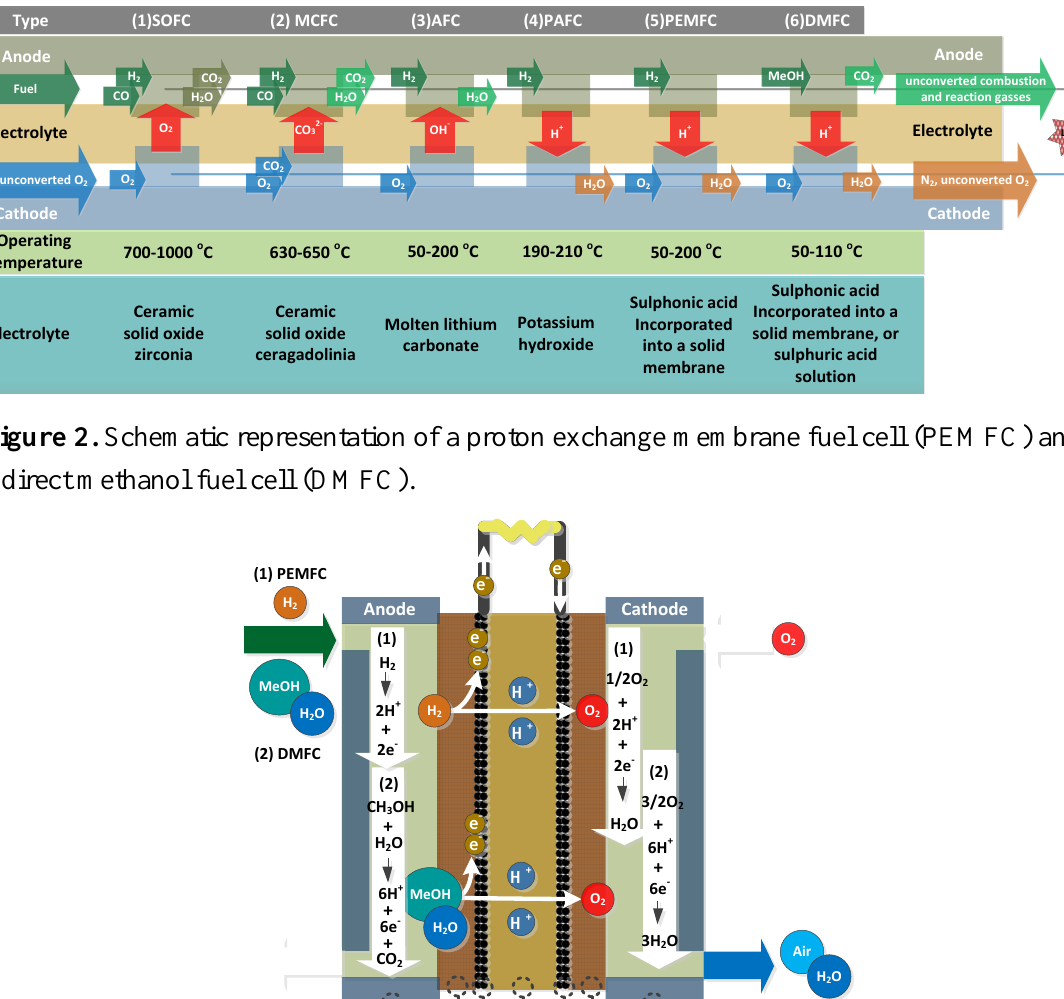
Figure 1. Comparison of the six main types of fuel cells.